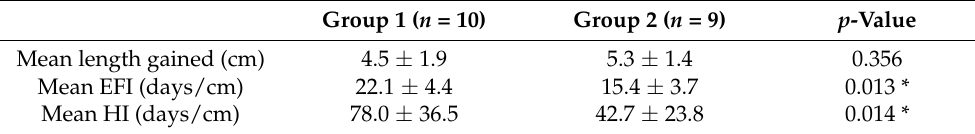
Table 2. The clinical outcomes of the included patients.